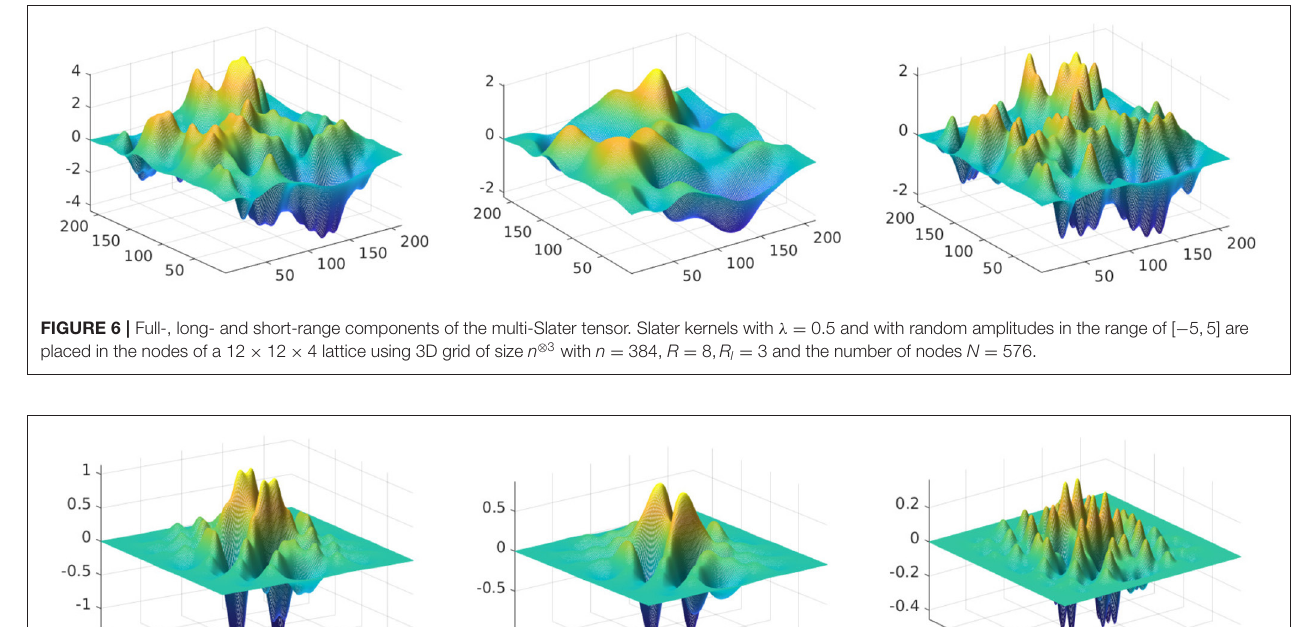
FIGURE 7 | Full-, long- and short-range components of the multi-Slater tensor. Slater kernels with λ (41) using the nodes of a 12